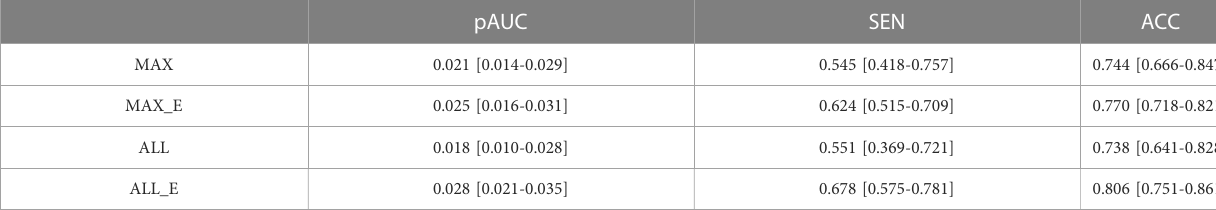
TABLE 3 Diagnostic performance of four ROI methods in the differentiation of adenomas from